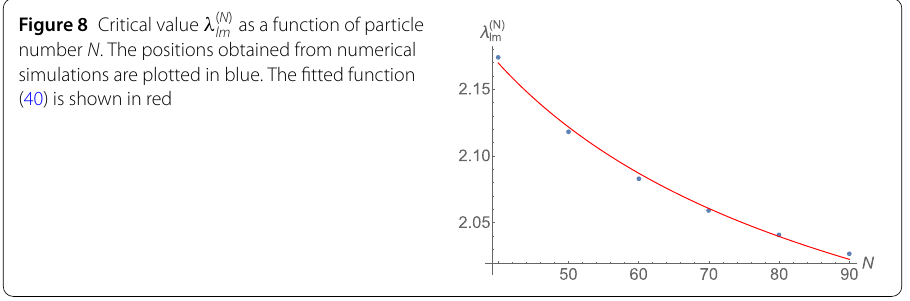
Figure 8 Critical value λ ( N ) as a function of particle lm number N . The positions obtained from numerical simulations are plotted in blue. The fitted function (40) is shown in